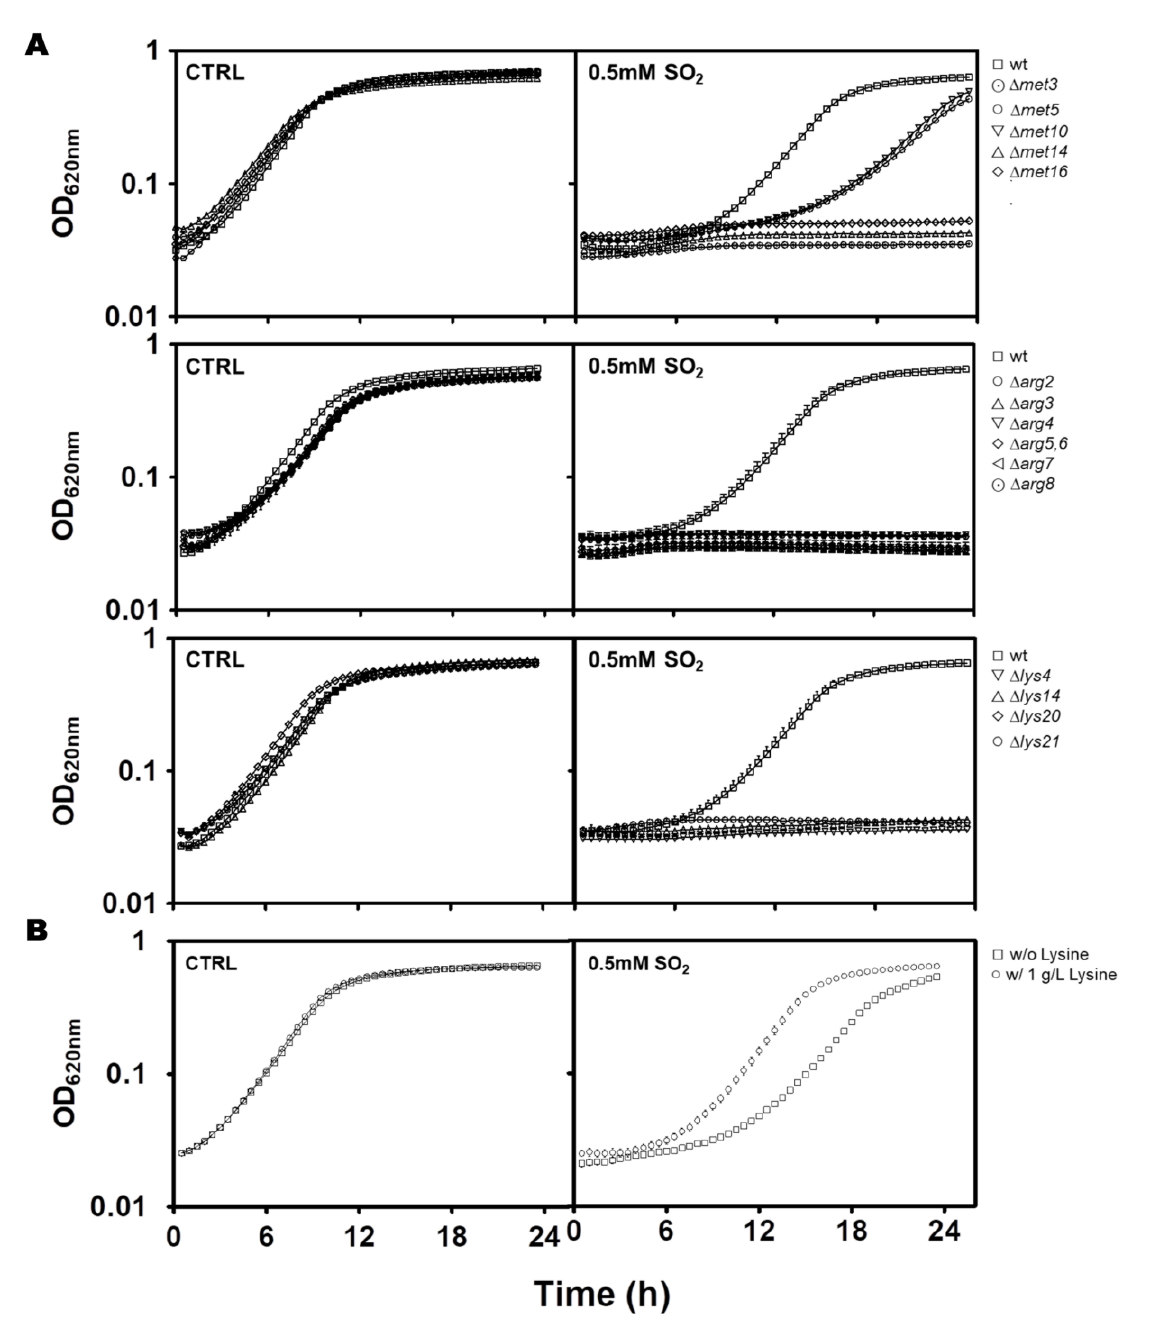
FIGURE 3. (A) Comparison of the susceptibility towards SO 2 of the mutants devoid of the expression of genes whose transcription is acti- vated in response to SO 2 in a Com2p-dependent manner. Cells of the parental strain (wt) and of the indicated deletion mutants were grown until mid-exponential phase in liquid MMB medium (at pH 3.5) and then used to inoculate the same basal medium either supple- mented (open symbols) or not supplemented with 0.5 mM SO 2 (filled symbols) (at pH 3.5). Cells were batch cultured at 30ºC and growth was monitored based on OD 620nm . The growth curves presented are representative of at least three independent growth experiments. (B) Wild-type strain was challenged for 24h in MMB pH 3.5 without and/or with 0.5 mM SO 2 supplemented with 1 g/L of OPEN ACCESS | www.microbialcell.com